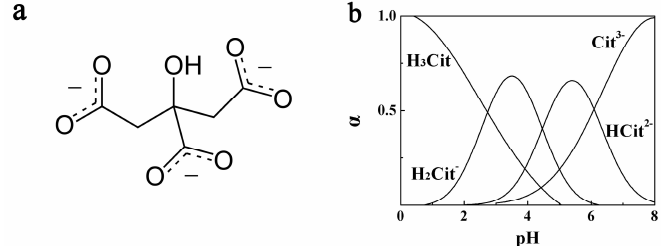
Figure 4. Some information of citrate. ( a ) Two − dimensional formula of citrate. ( b ) Distribution diagram of the citric forms when the pH value changes.